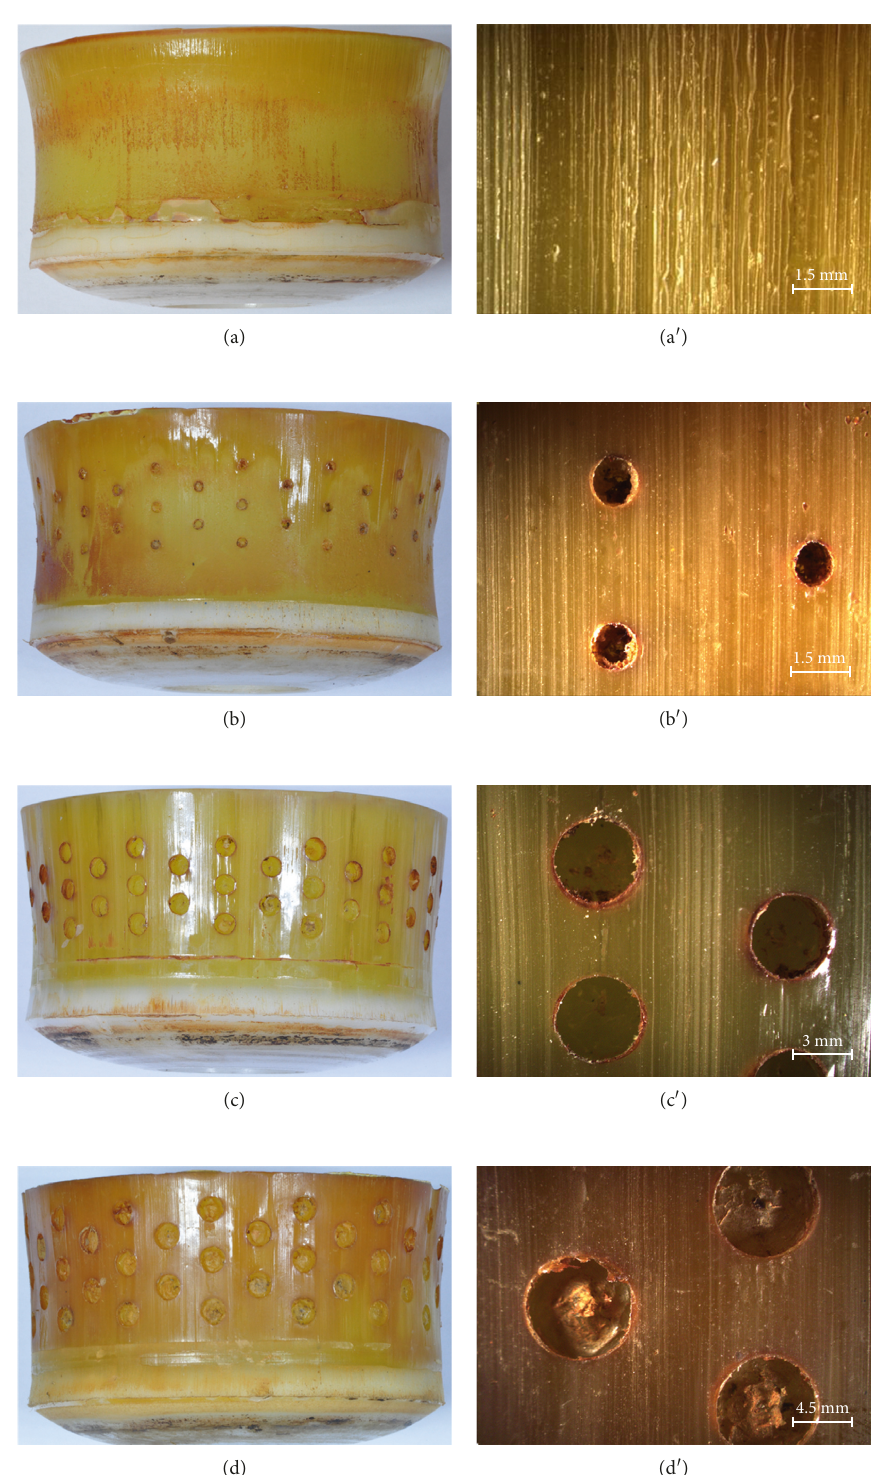
Figure 4: Surface wear patterns of pistons with different dimple diameters in the service life test: (a) L-Standard piston, (b) L-D1 piston, (c) L-D2 piston, and (d) L-D3 piston. (a ′ , b ′ , c ′ , d ′ ) are partial enlarged pictures of (a, b, c,